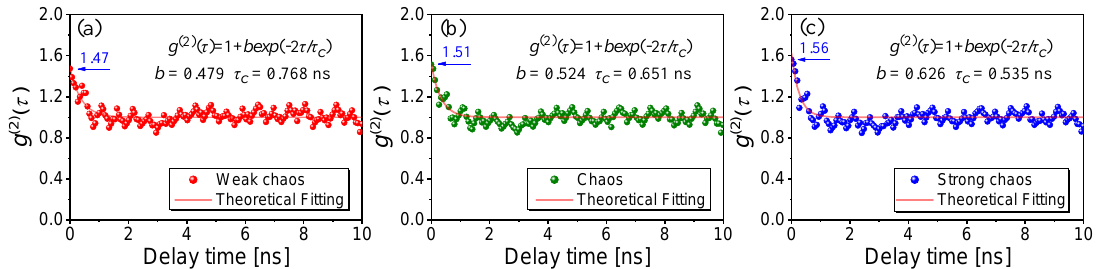
Figure 4. The ninth order correction of second order photon correlation and the theoretical fitting. The bias current J = 1.5Jth and feedback strength ( a ) η = 2.66%, ( b ) 8.87%, ( c ) 30.31% are the same as those used in Figure 2.